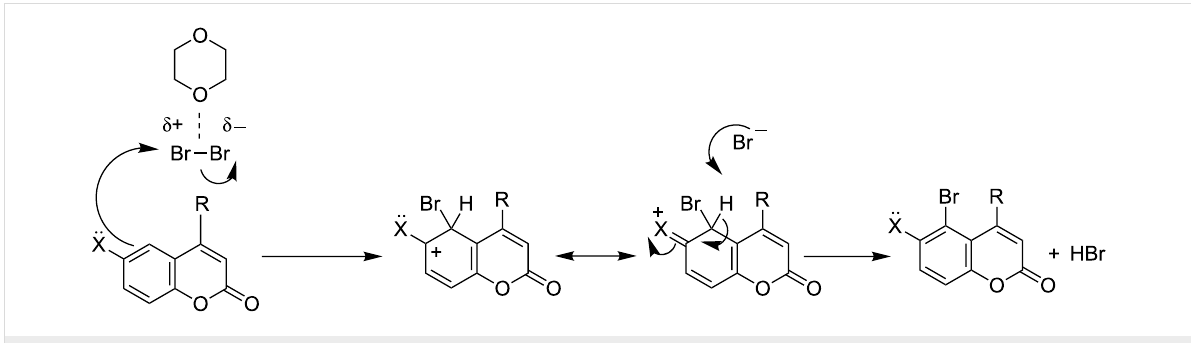
Figure 2: Mechanism for bromination of the carbocyclic